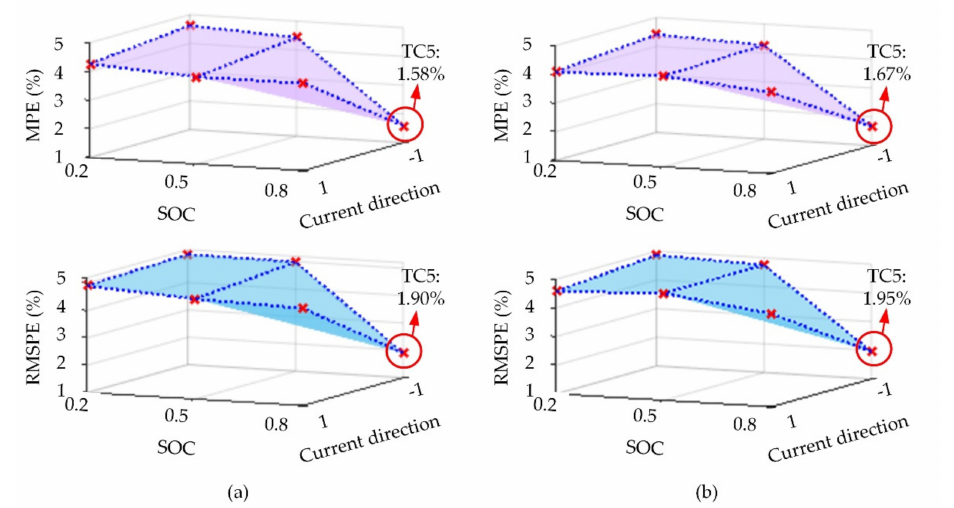
Figure 14. The diagram of the mean percentage error and root-mean-squared percentage error considering the state of charge level and current direction (minus one indicates the charging direction and plus one indicates the discharging direction). ( a ) Approximate entropy-based method; ( b ) Sample entropy-based